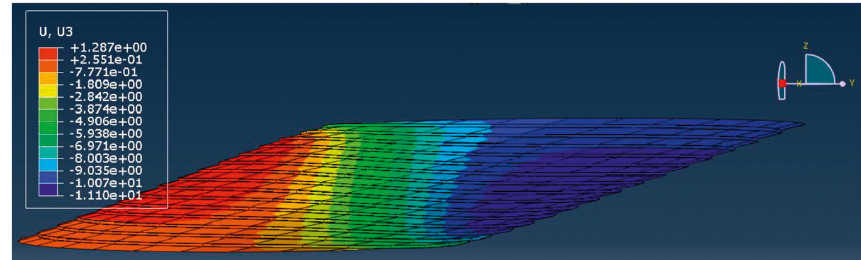
Figure 23: Vertical displacement cloud of the bearing under 400% ultimate compression shear.